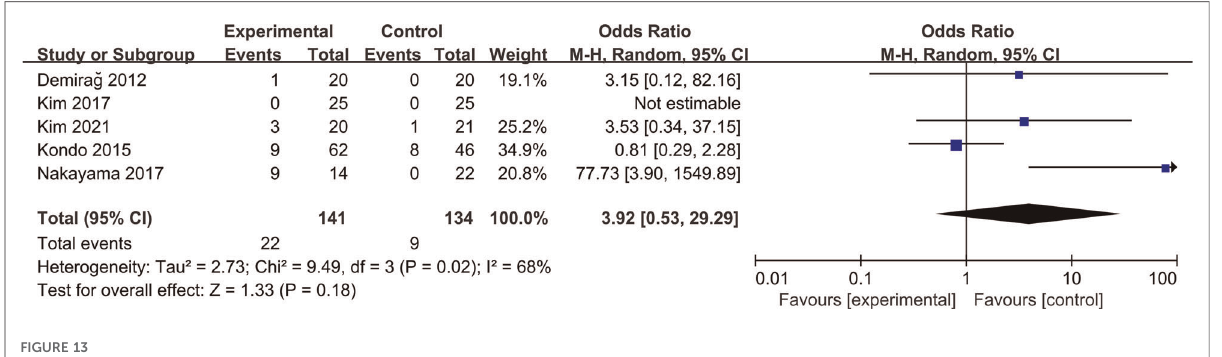
FIGURE 13 Forest pot for Cyclops